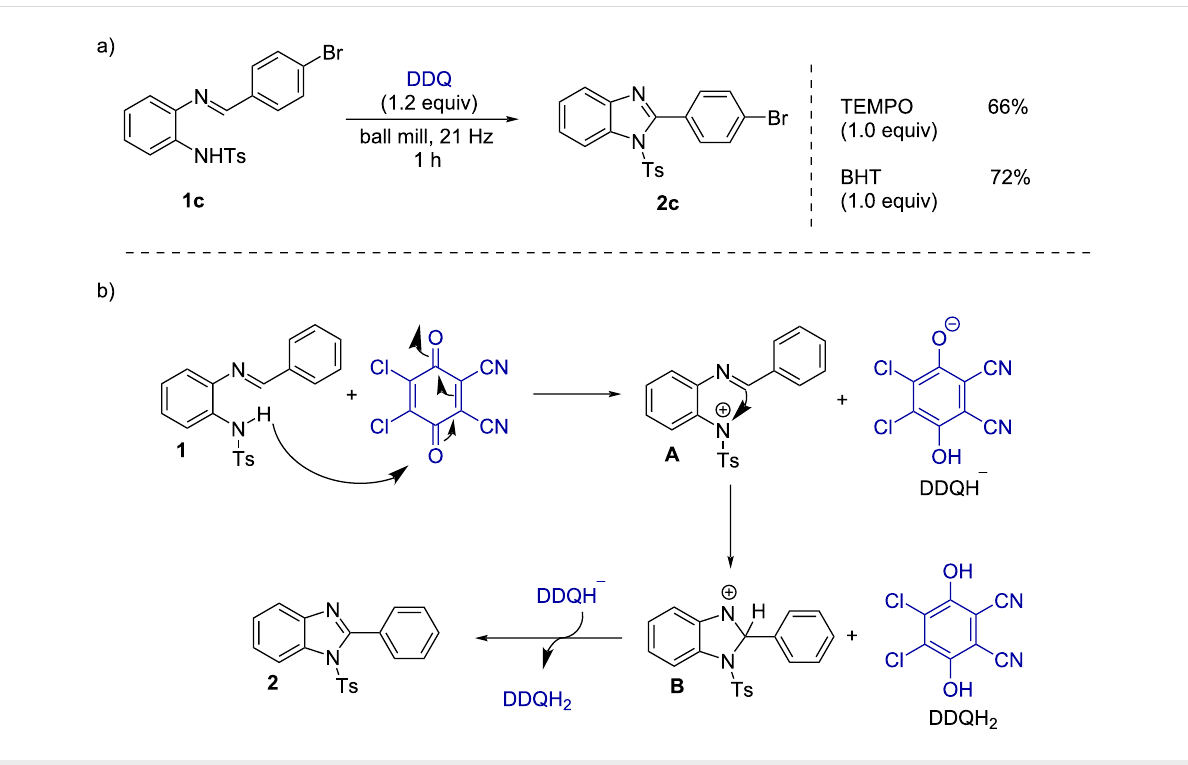
Figure 5: a) Control experiment and b) Plausible mechanism.